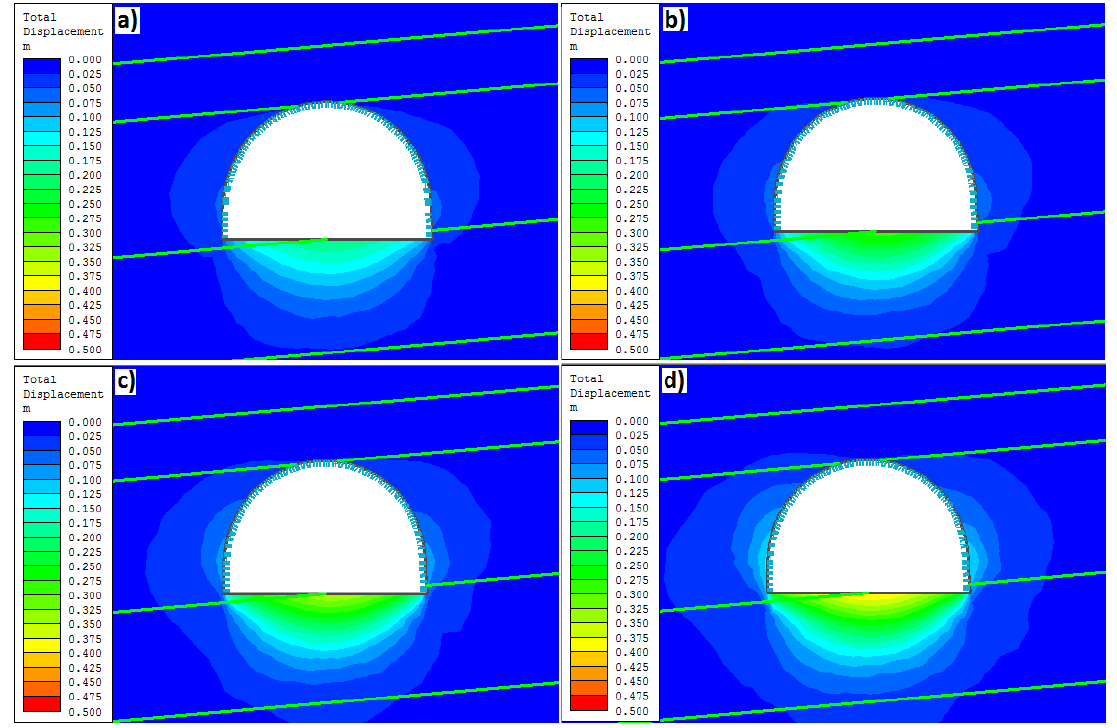
Figure 8. Results of numerical modeling of rock deformation around roadway D-2 for elasto-plastic rock mass with reinforcement.